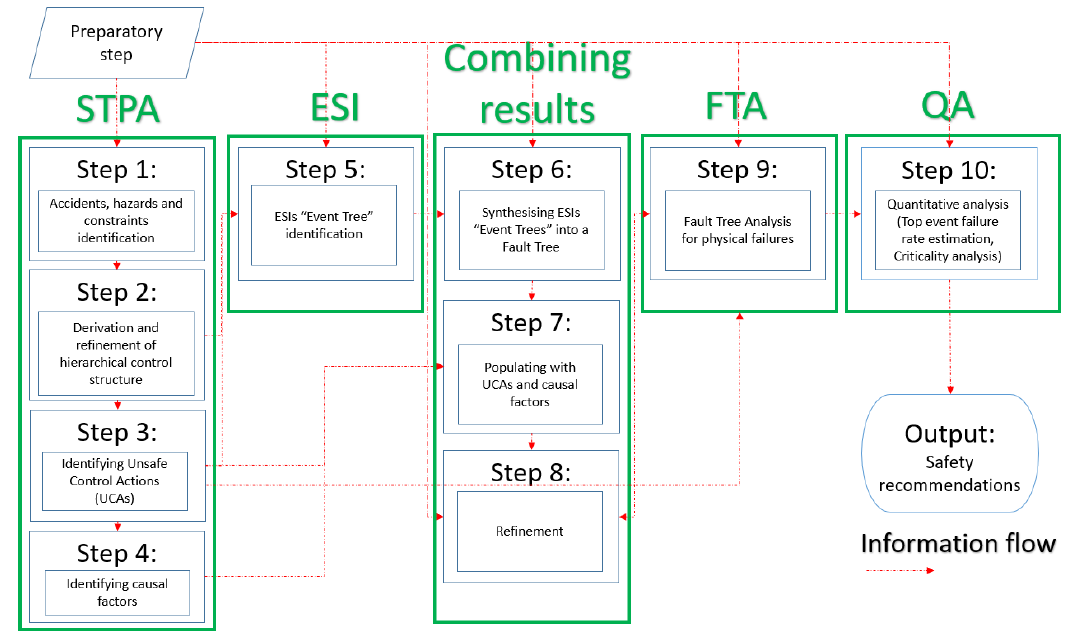
Figure 1. CASA method flowchart.